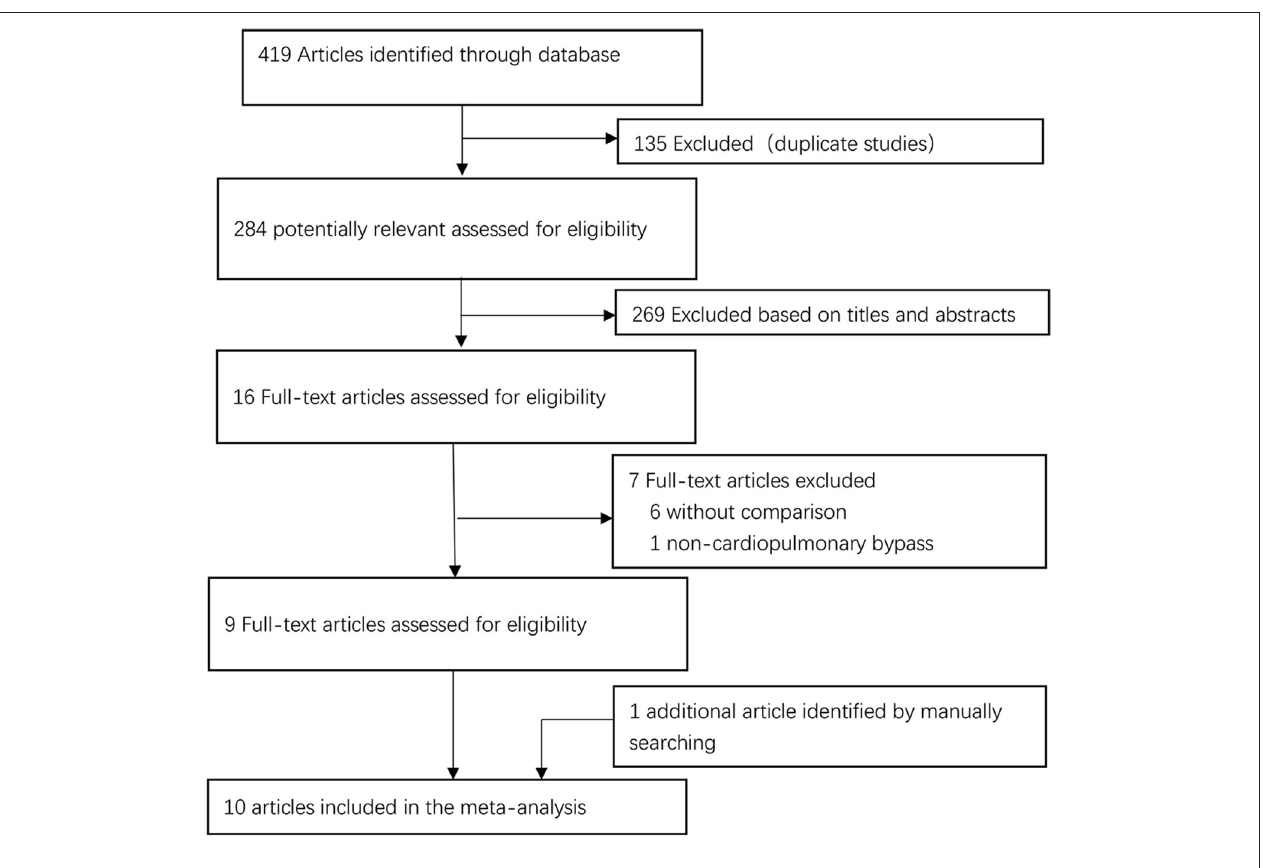
FIGURE 1 | Study selection flow diagram.